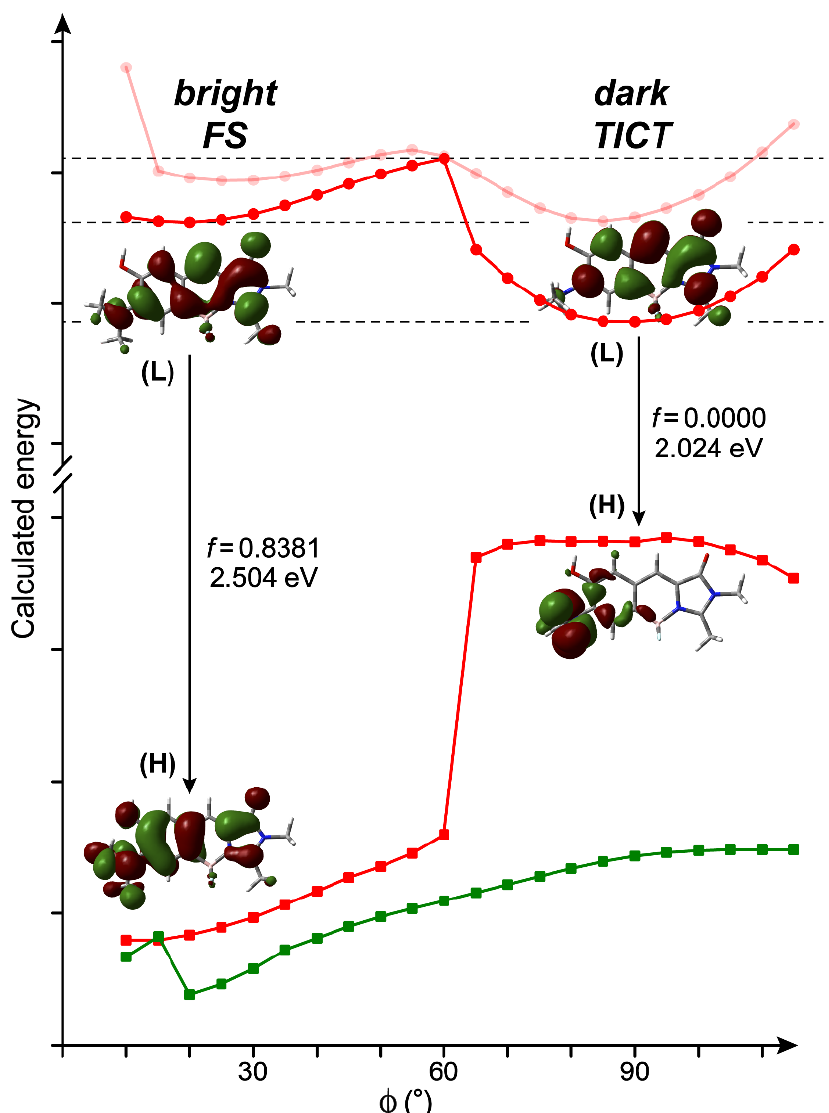
Figure 2. Calculated potential energy surfaces (PESs) along the twisting coordinate of the dimethyl- amine in S 0 and S 1 for compound 1 . Red circles, red squares, and green squares denote the optimized S 1 energy, S 0 energy at the optimized S 1 geometry, and optimized S 0 energy, respectively. The grayed-out red trace with red circles displays the S 1 energy scan with –OH pointing toward –NMe 2 on the phenol ring. Electron density distributions of HOMO (H) and LUMO (L) are shown for the FS and TICT states, accompanied by the S 1 → S 0 transition oscillation strengths and energy gaps. Notably, the orientation of the –OH group has noticeable impacts on the calculated energy and even potential energy surface (PES) profile in some nonpolar solvents. The calculated energy path with –OH pointing toward –NMe 2 yields consistently higher energy than that with –OH pointing away from –NMe 2 in S 1 (Figure S3). Therefore, the latter orientation with less steric hindrance is considered the preferred structure during the –NMe 2 twisting process following photoexcitation. For the former orientation, TICT is absent for dioxane and toluene as the PES profile is drastically changed (see Figure S3, dark traces in the last two panels). The ground state (S 0 ) scan always converges to the same PES with –OH pointing away from –NMe 2 regardless of the initial set-up orientation, confirming the preferred –OH group orientation in solution at